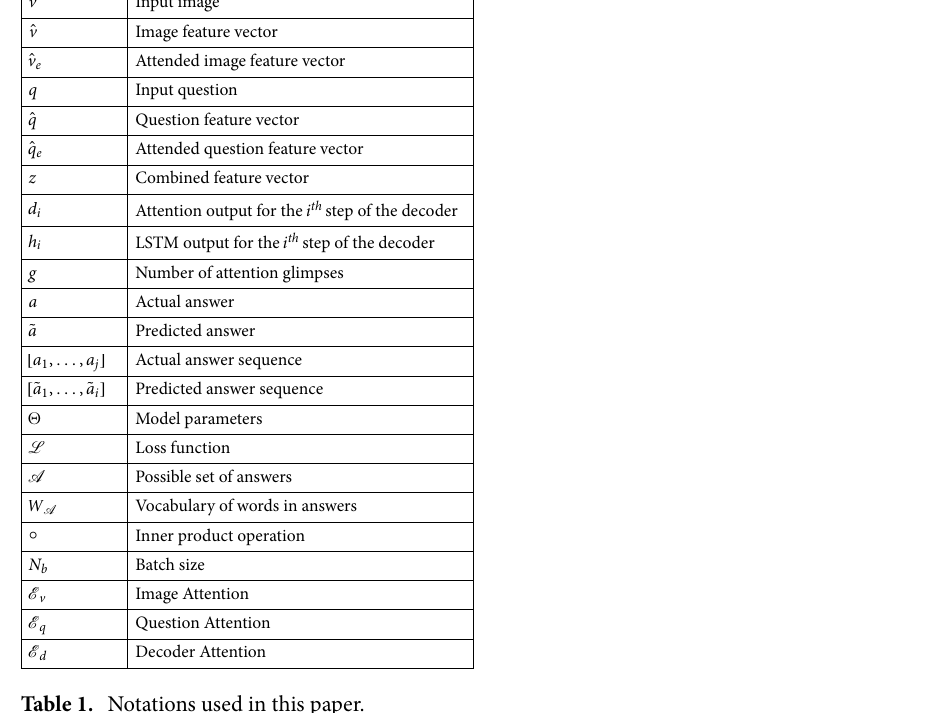
Table 1. Notations used in this